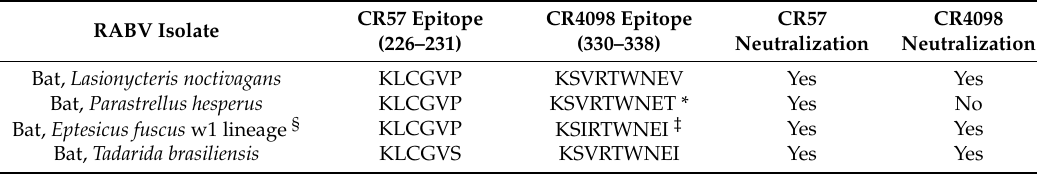
Table 4. Bat RABV isolates used in the animal studies. RABV